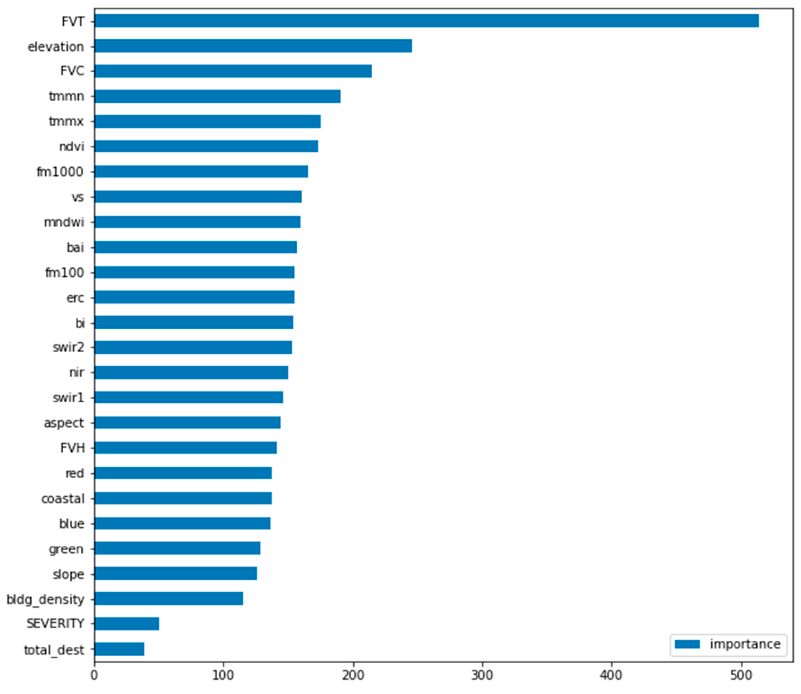
Figure 4. Random forest model training and classification to replace non-burnable FM40 classes with burnable classes in the newly defined WUI.